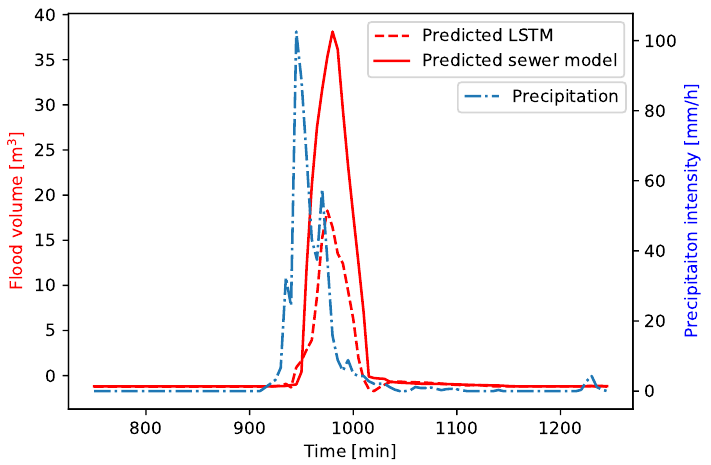
Figure 16. Flood volume time series, for the LSTM network validated on historic data, at a manhole in the southeast of the area (NSE = −